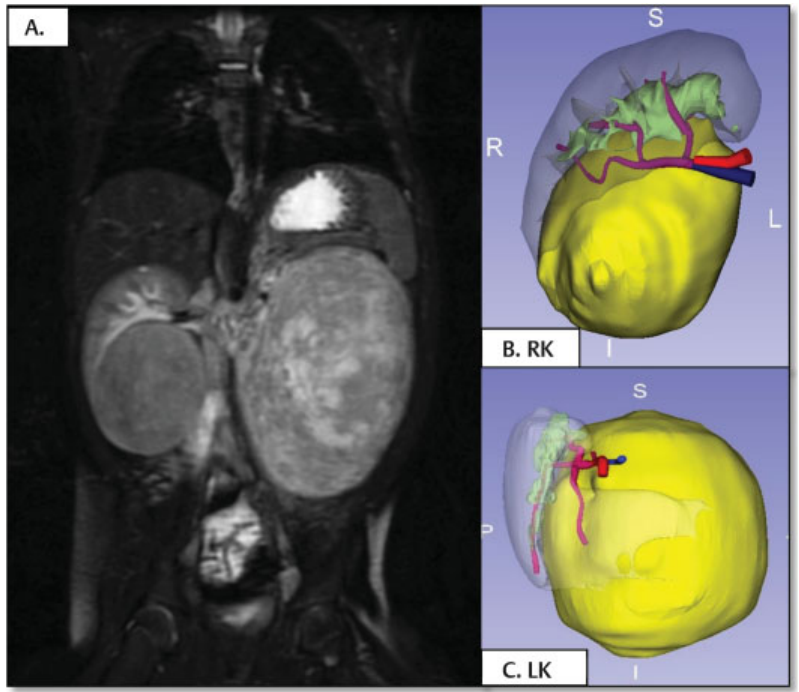
Fig. 2 Case 1. ( A ) Coronal MRI section showing both kidneys affected by Wilms tumor, con fi rming the large size of the left tumor mass. ( B and C ) Volumetric reconstructions of both tumors. Healthy renal parenchyma susceptible to nephron sparing surgery was proved. LK, left kidney; MRI, magnetic resonance imaging; RK, right